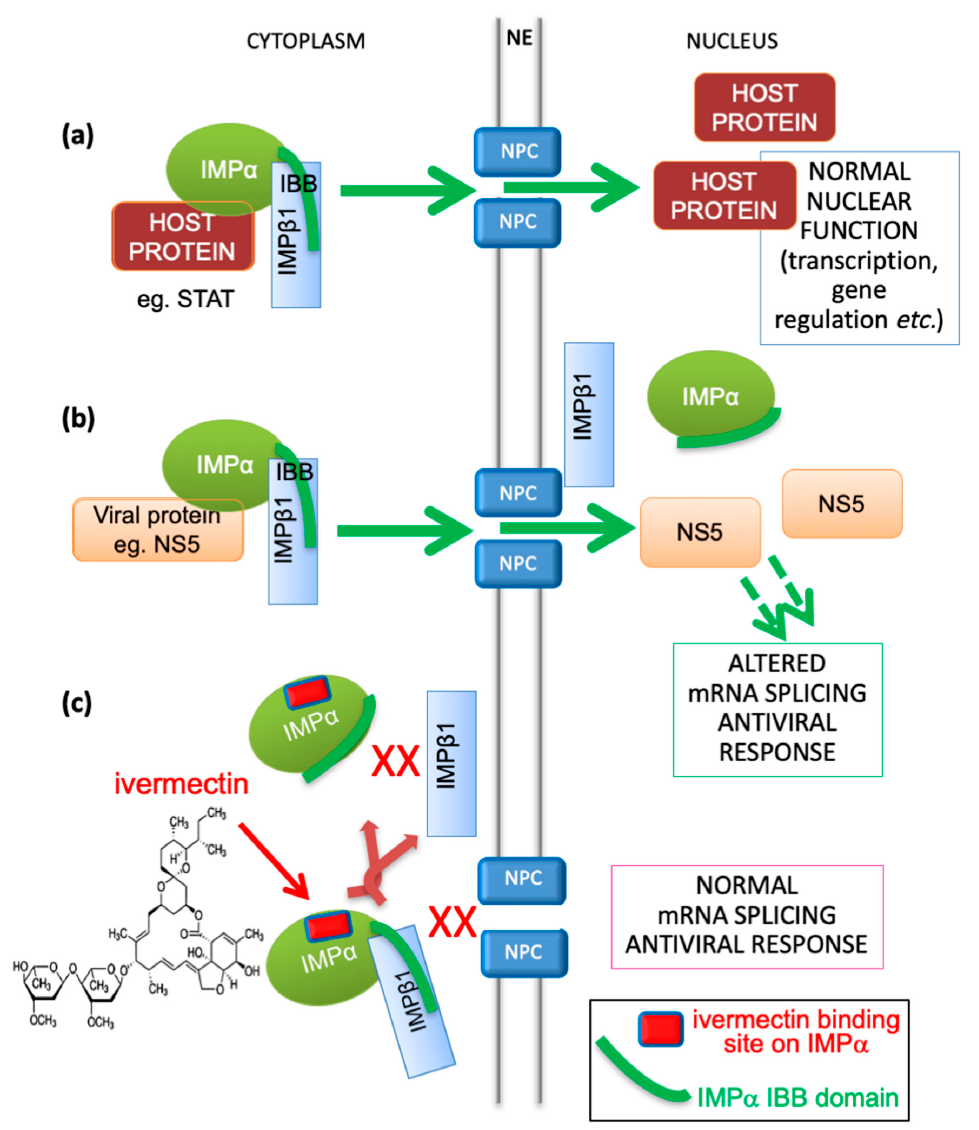
Figure 1. Schematic showing IMP α ’s role in nuclear transport of host and viral proteins, and mechanism of inhibition by ivermectin. ( a ) Host proteins, such as members of the STAT or NF- κ B transcription factor families, localize in the nucleus through the action of the IMP α / β 1 heterodimer, where the “IBB” (IMP β -binding) region of IMP α (green curved line) is bound by IMP β 1 to enable cargo recognition by IMP α within the heterodimer; IMP β 1 subsequently mediates transport of the trimeric complex through the nuclear pore (NPC, nuclear pore complex) embedded within the nuclear envelope (NE) into the nucleus. This is followed by release within the nucleus to enable the transcription factors to carry out normal function in transcriptional regulation, including in the antiviral response. IMP α can only mediate nuclear import within the heterodimer with IMP β 1. ( b ) In viral infection, specific viral proteins (e.g., NS5 in the case of DENV, ZIKV, WNV) able to interact with IMP α utilize the IMP α / β 1 heterodimer to access the nucleus and antagonize the antiviral response [14,27,28]. This is critical to enable optimal virus production as shown by mutagenic and inhibitor studies. Which SARS-CoV-2 proteins may access the nucleus in infected cells has not been examined (see Section 3). ( c ) The IMP α targeting compound ivermectin binds to IMP α (binding site shown as red lozenge) both within the IMP α / β heterodimer to dissociate it, and to free IMP α to prevent it binding to IMP β 1, thereby blocking NS5 nuclear import [11]. GW5074 (see Table 1) has been shown to exhibit a similar mechanism